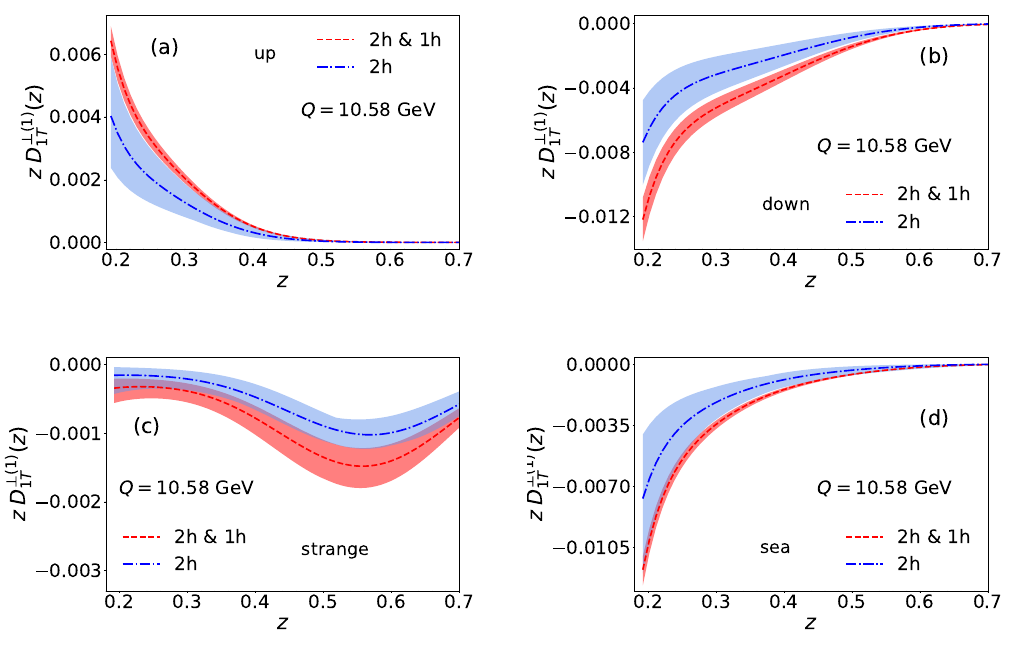
Figure 10 . First moments of the polarizing FFs, for the up (a), down (b), strange (c) and sea (d) quarks, as obtained from the combined fit (red dashed lines) and the 2-h fit (blue dot-dashed lines). The corresponding statistical uncertainty bands are also